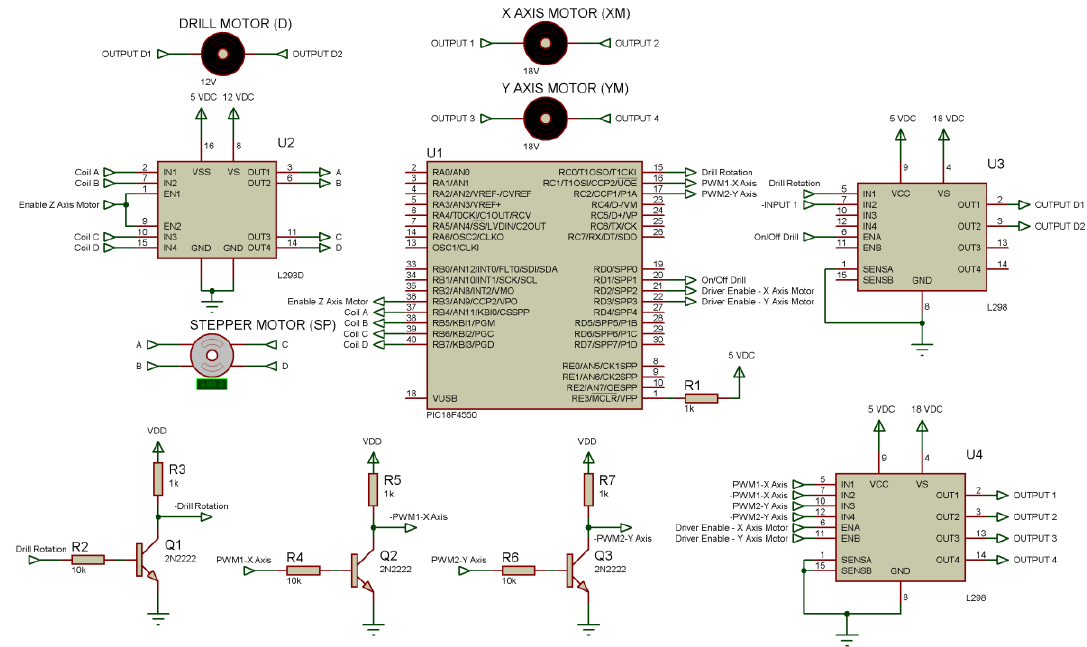
Figure 11. Schematic diagram of the power stage.